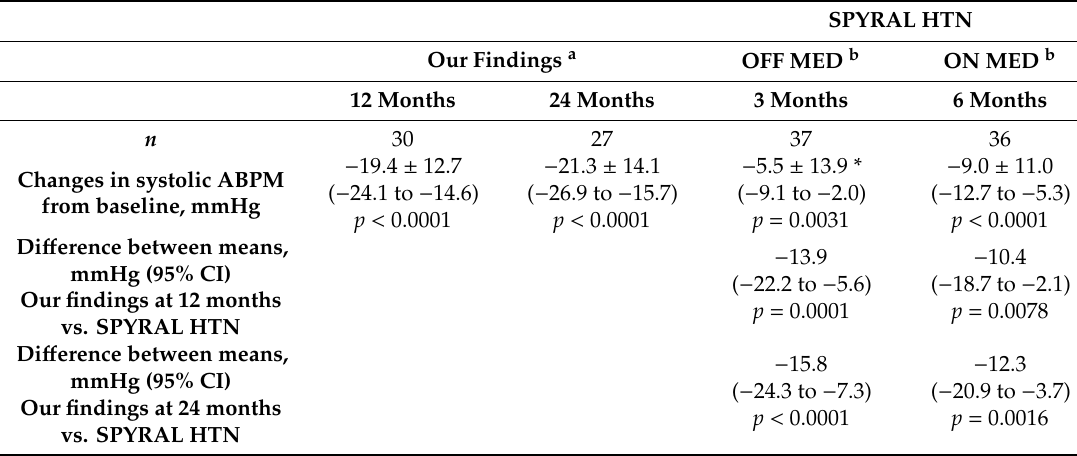
Table 4. Changes in systolic ABPM after renal denervation.